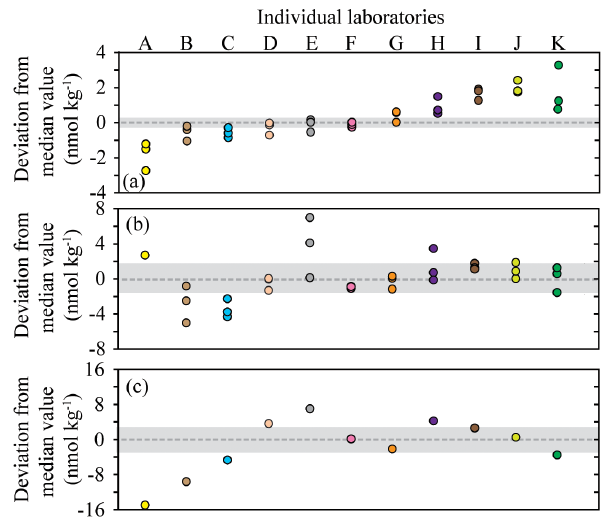
Figure 2. Deviation from the median methane concentration (re- ported as absolute values in nmolkg − 1 ) for the seven Baltic Sea samples. The batches of seawater samples: BAL1, BAL3, and BAL6 (a) ; BAL4, BAL5, and BAL7 (b) ; BAL2 (c) . The shaded grey area indicates values ≤ 5% of the median concentration. The color scheme for each laboratory dataset is identical to that used in Fig. 1 and the letters allocated to each dataset are to facilitate cross- referencing in the text. Note that the y axis scale varies between the